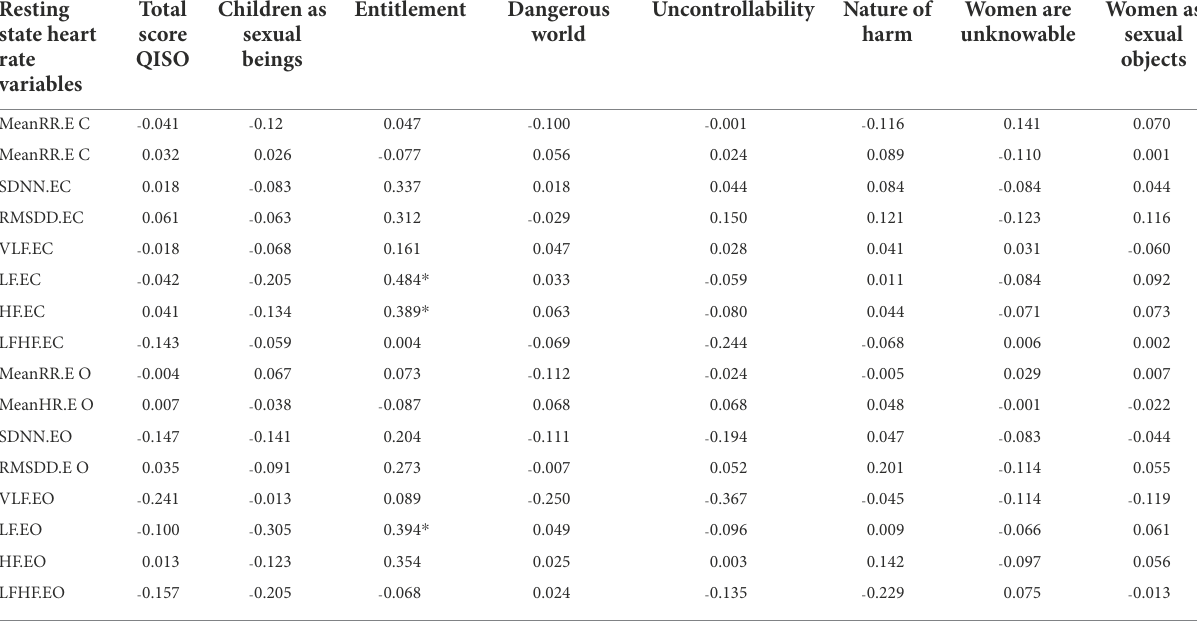
TABLE 7 Correlations between the experimental QITSO and the resting state heart rate data. Resting state